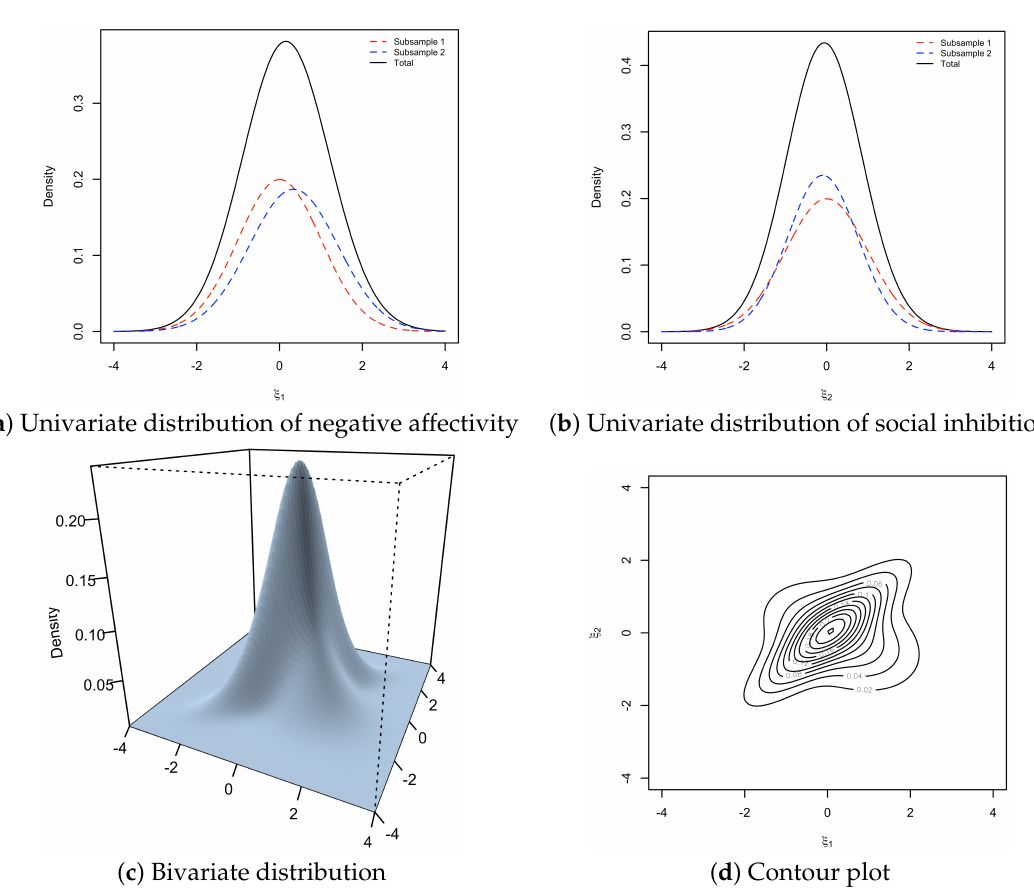
Figure 2. The univariate distributions ( a , b ), bivariate ( c ) and contour plot ( d ) of the estimated mixture of bivariate normal distributions for the Type D personality